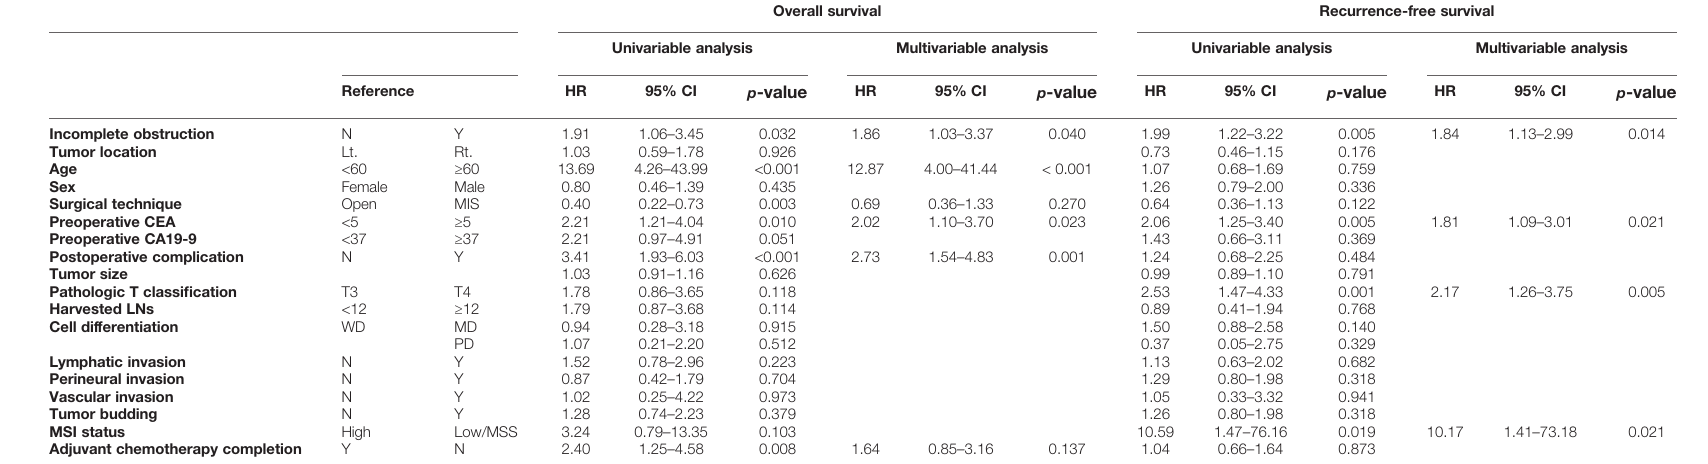
TABLE 5 | Univariable and multivariable Cox regression analysis of overall survival and recurrence-free survival of stage II colon cancer. Overall survival Recurrence-free survival Univariable analysis Multivariable analysis Univariable analysis Multivariable analysis